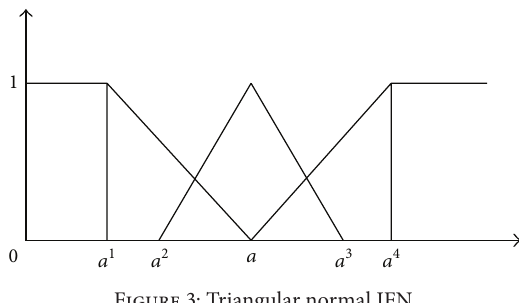
Figure 2: TIFN. Figure 3: Triangular normal